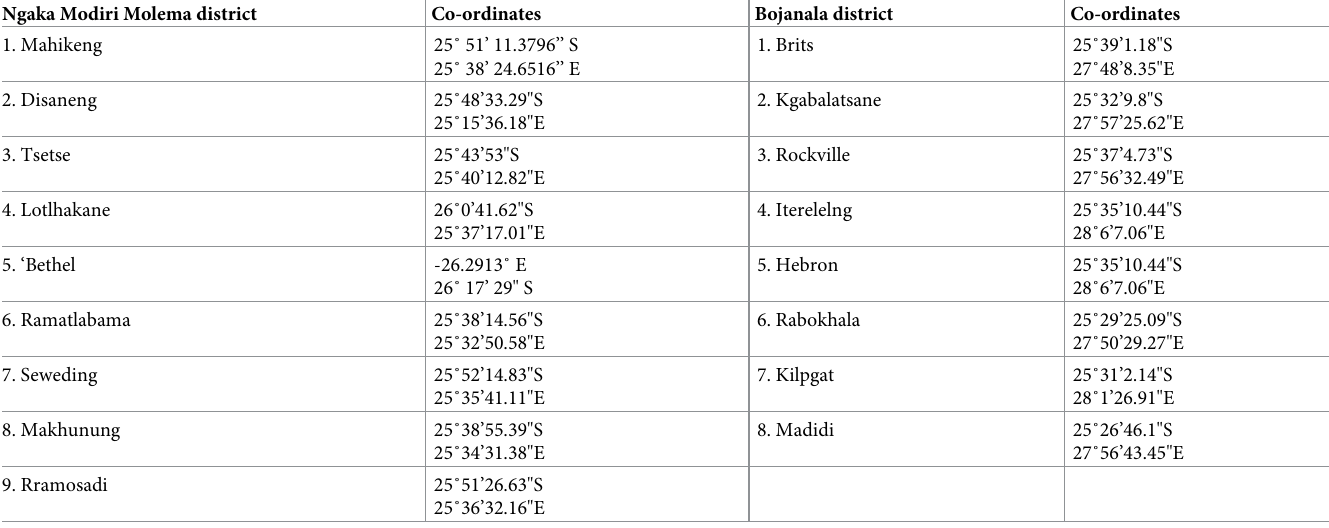
Table 1. Selected study sites (villages and towns) in Ngaka Modiri Molema and Bojanala districts of North West Province, South Africa. Ngaka Modiri Molema